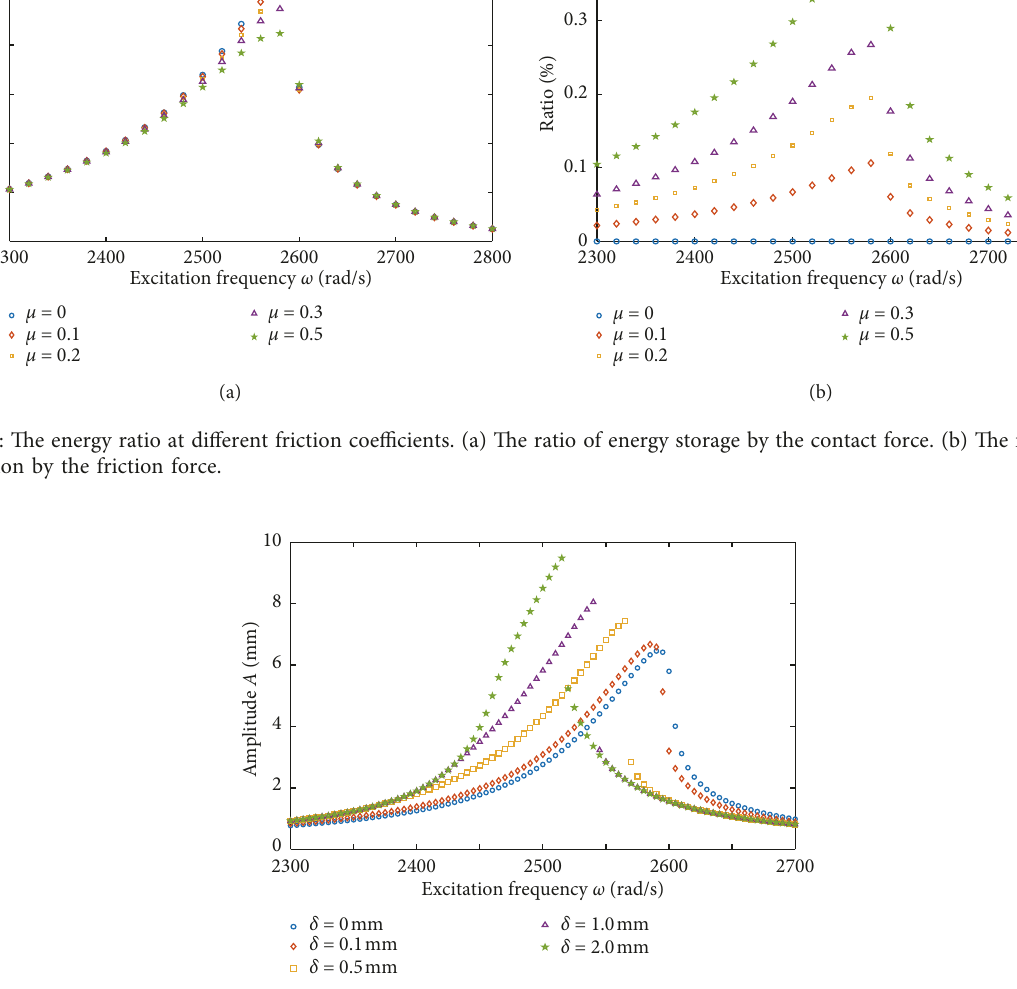
Figure 13: The amplitude-frequency curves at different clearances.